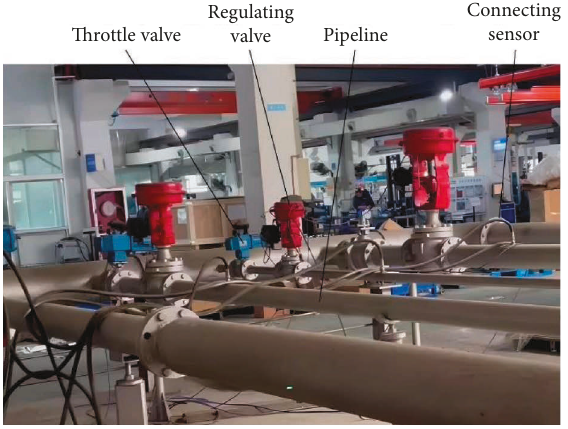
Figure 49: Control valve noise and cavitation test.